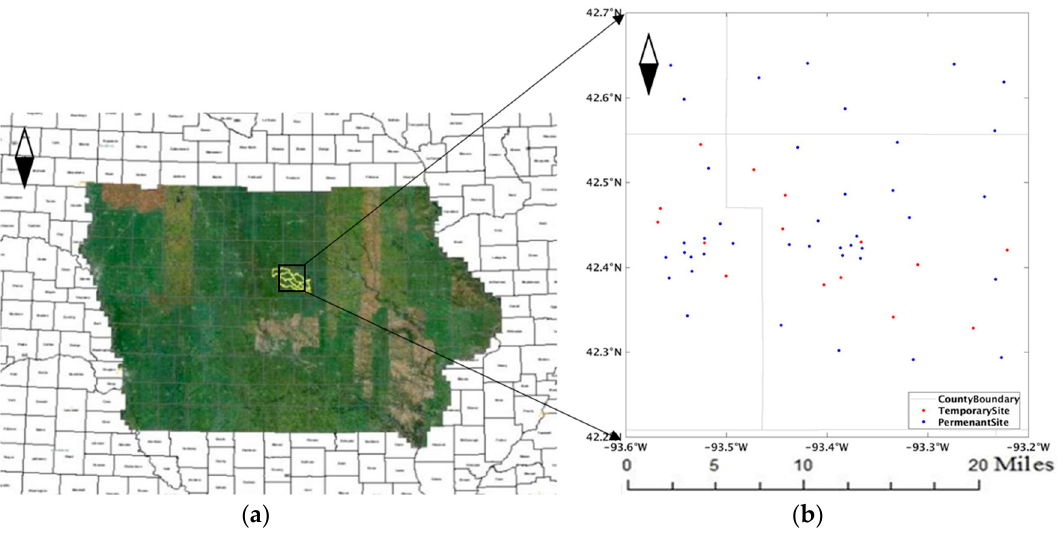
Figure 1. ( a ) Location of South Fork Experimental Watershed (from Michael H. Cosh); ( b ) the locations of permanent (red) and temporary (blue) sites in the study area.